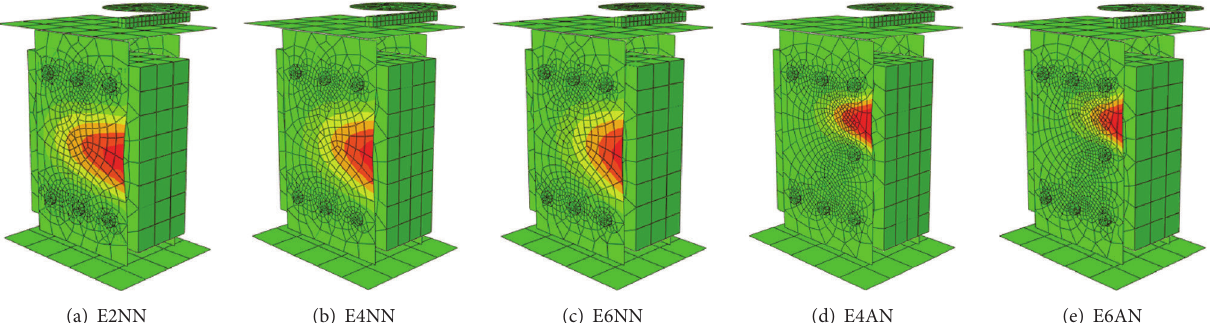
Figure 7: Failure modes of models with different plate thickness and narrower bolt densification: (a) E2NN, (b) E4NN, (c) E6NN, (d) E4AN, and (e) E6AN.